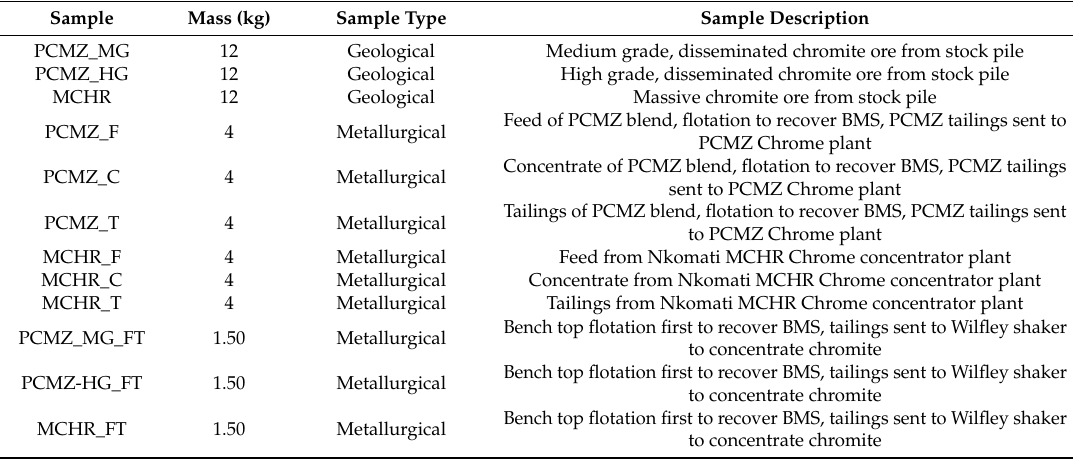
Table 1. Details of the samples collected for this study.